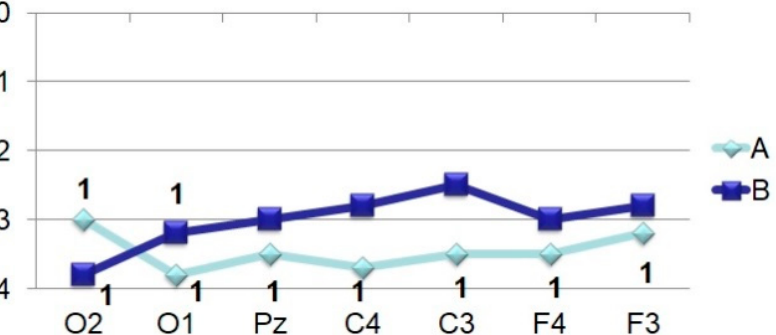
Figure 5. Averaged values of amplitudes and factor characteristics of amplitudes and PL of the N 250 ERP component. Note. Legend in Figure 3.